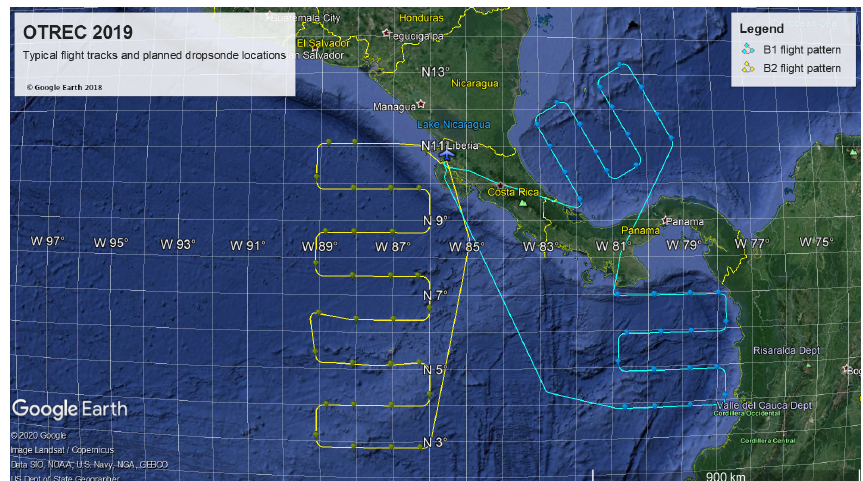
Figure 1. B1 (blue) and B2 (yellow) flight patterns and typical dropsonde locations.